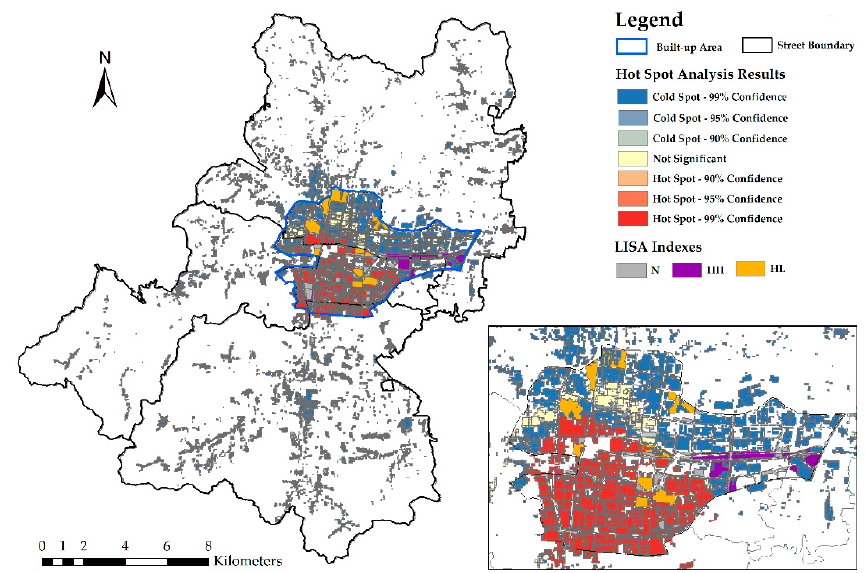
Figure 6. Hot spot analysis results of population and overlaid results with the local indicators of spatial association (LISA) of public open spaces area.